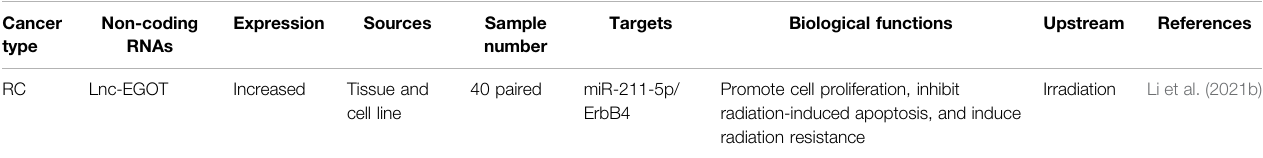
Frontiers in Cell and Developmental Biology |